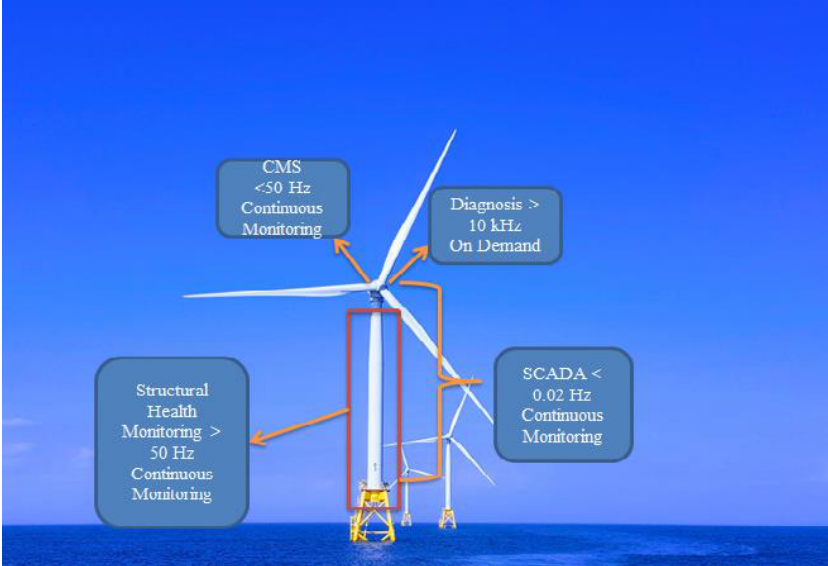
Figure 15. SCADA and CMS systems common description and specifications of use.